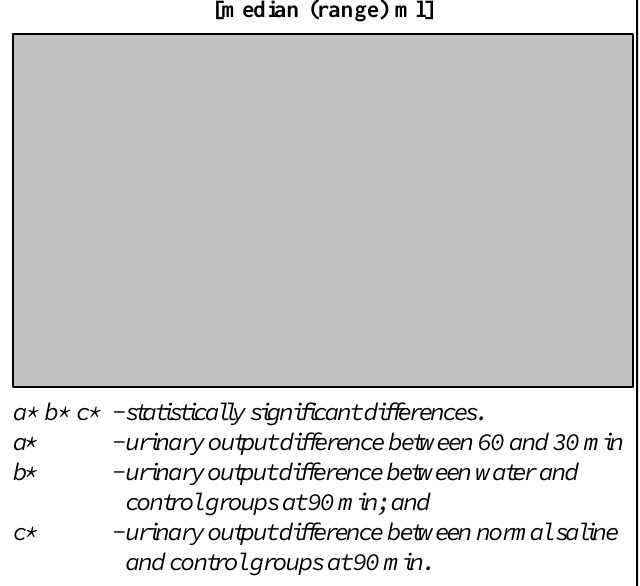
Table II : Urinary output of normal individuals [median (range) ml]